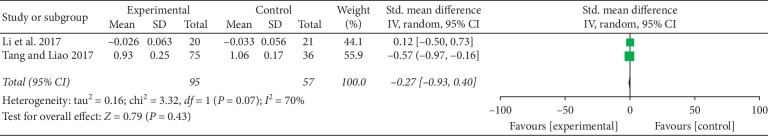
BCVA forest map after follow-up.